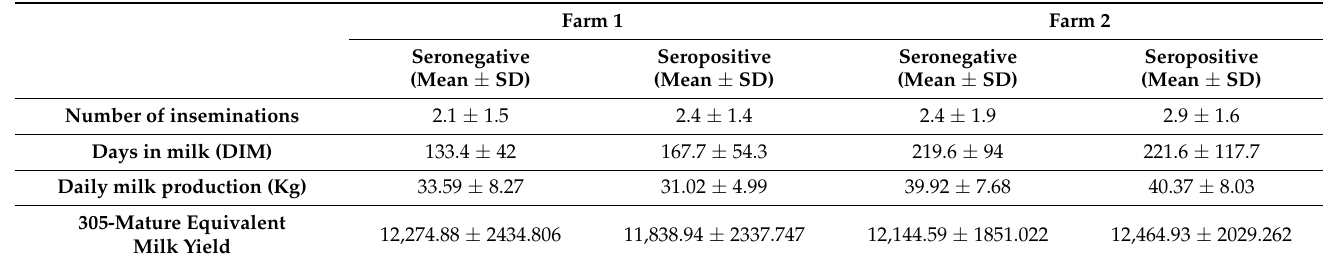
Table 4. Reproductive and productive performances in seronegative vs. N. caninum seropositive cows from two cattle farms in northern